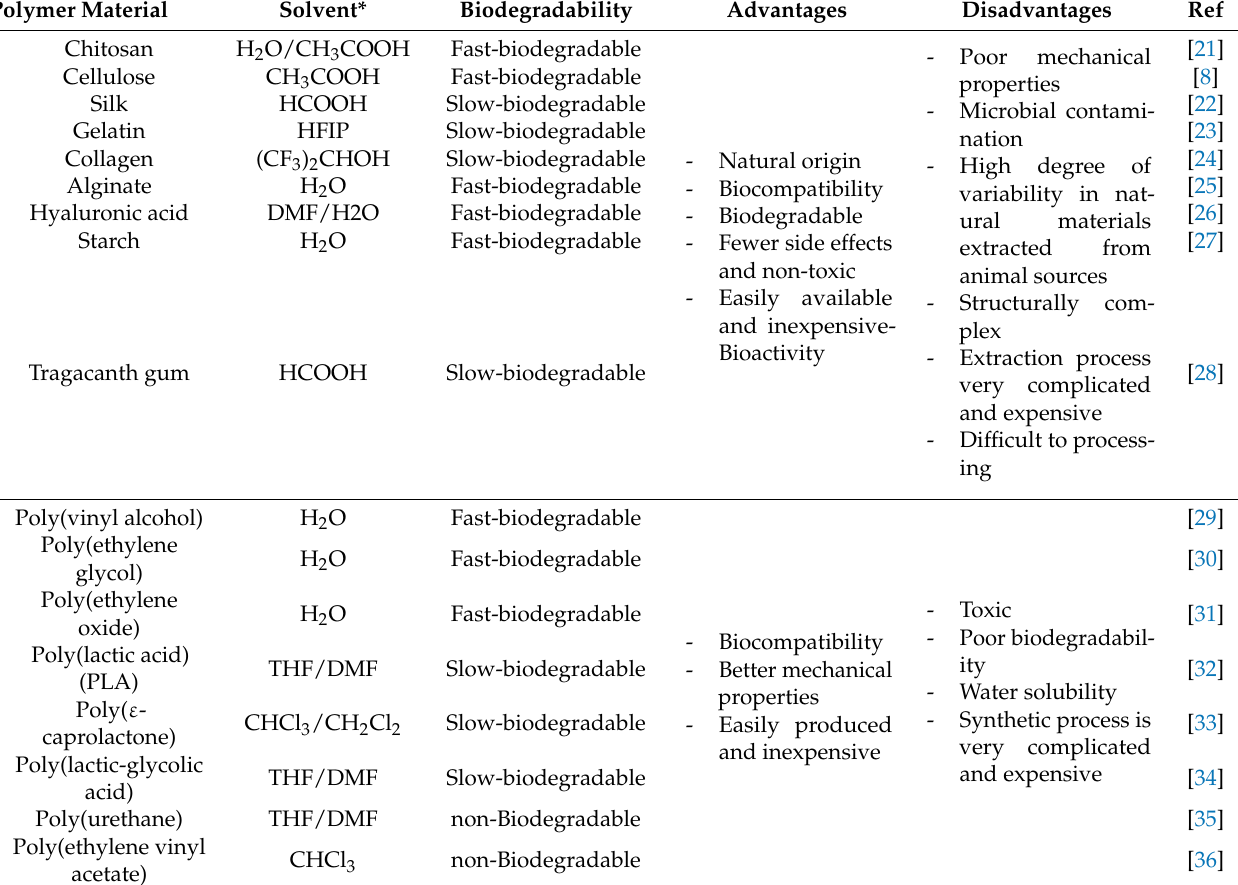
Table 2. Natural polymers and synthetic polymers for nanofiber